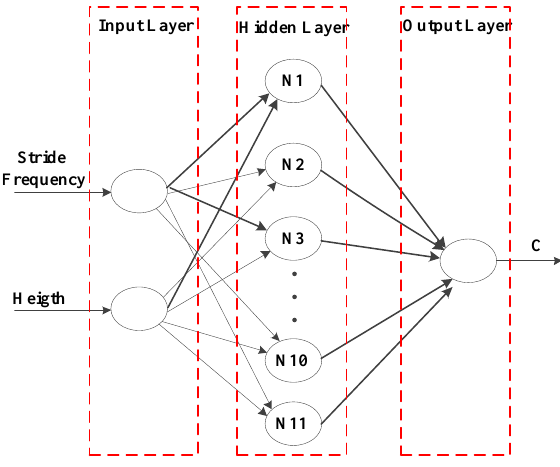
Figure 5. Topological structure of the BP neural network.